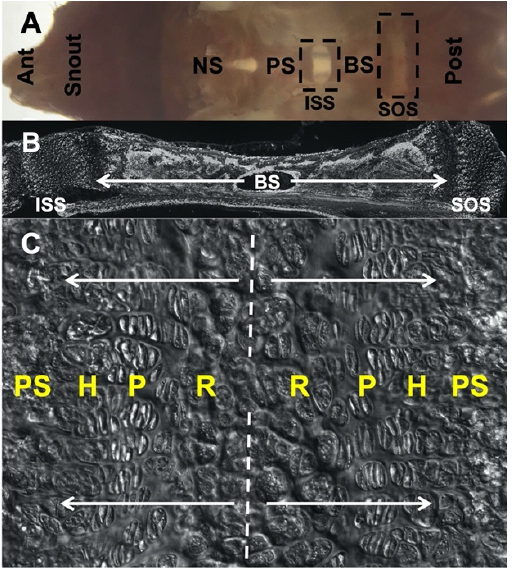
Figure 1. Morphology of cranial base and spheno-occipital synchondrosis (SOS), C57BL/6 mouse at postnatal day 28. ( A ) Gross morphology of dissected cranial base positioned in an anteroposterior manner and taken from the dorsal view following the removal of the brain and cranial vault. ( B ) Sagittal section of inter-sphenoid synchondrosis (ISS), basisphenoid bone and SOS. ( C ) Magnified image highlighting bidirectional arrangement of chondrocyte layers in SOS. Ant: anterior, NS: nasal septum, PS: pre-sphenoid, BS: basisphenoid, Post: posterior, ISS: inter-sphenoid synchondrosis, SOS: spheno-occipital synchondrosis, R: resting zone, P: proliferating zone, H: hypertrophic zone, PS: primary spongiosa.